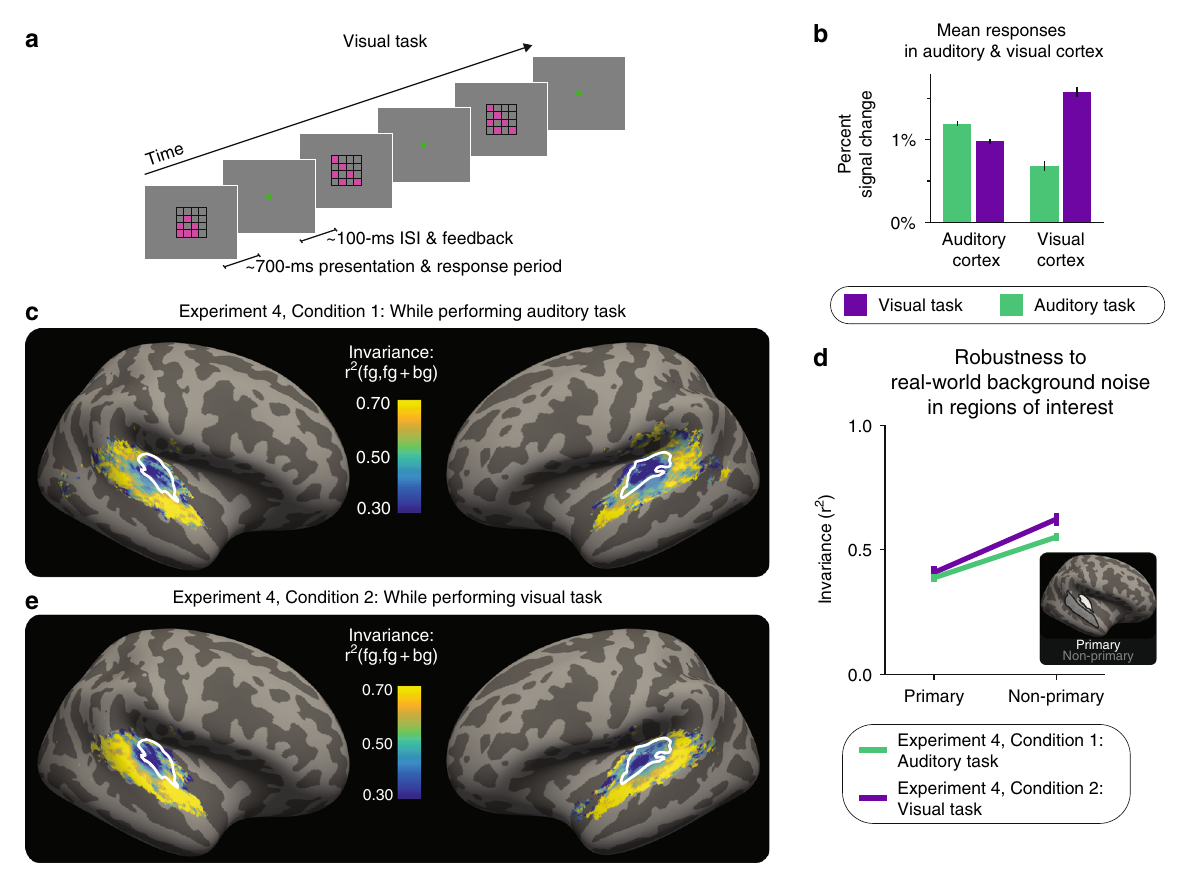
Fig. 4 Increased invariance in non-primary areas is robust to inattention. a Schematic of visual task. b Mean responses in auditory and visual cortex during each task. Error bars are within-participant SEM. c The results of Experiment 4, Condition 1 ( n = 21): map of invariance metric for real-world background noises during the auditory task, averaged across participants and hemispheres. White outlines: primary-like areas, de fi ned anatomically. d Median of invariance metric in a primary and non-primary region of interest (ROI), averaged across participants and hemispheres. Error bars are within-participants SEM. Inset: outlines of anatomical ROIs. e The results of Experiment 4, Condition 2 ( n = 21): map of invariance metric for real-world background noises during the visual task, averaged across participants. Plotting conventions, including colorscale, are identical to ( c